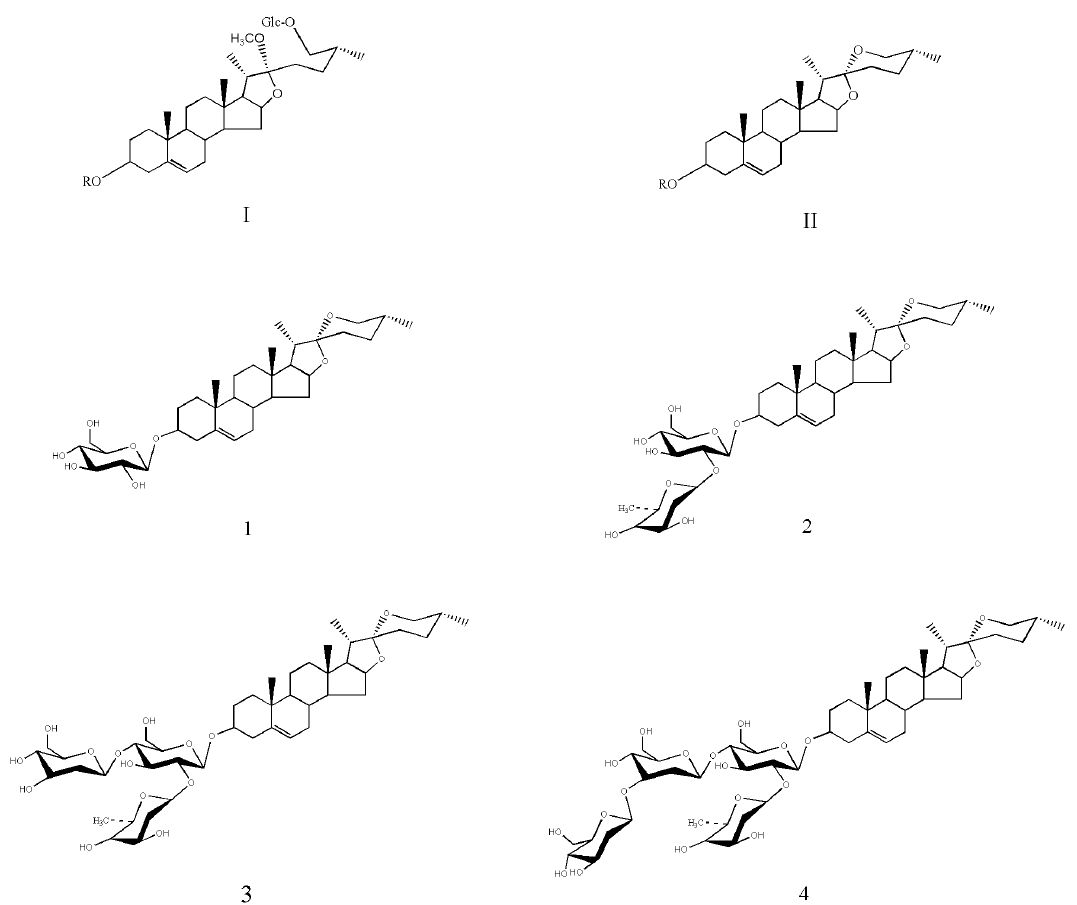
Figure 1. Chemical structures of steroidal saponins in plants. The steroidal saponins were mainly divided into two types, furostanol-type ( I ) and spirostanol-type ( II ). Spirostanol-type saponins in DZW primarily include trillin ( 1 ), prosapogenin A of dioscin ( 2 ), deltonin ( 3 ), and zingiberensis newsaponin ( 4 ).